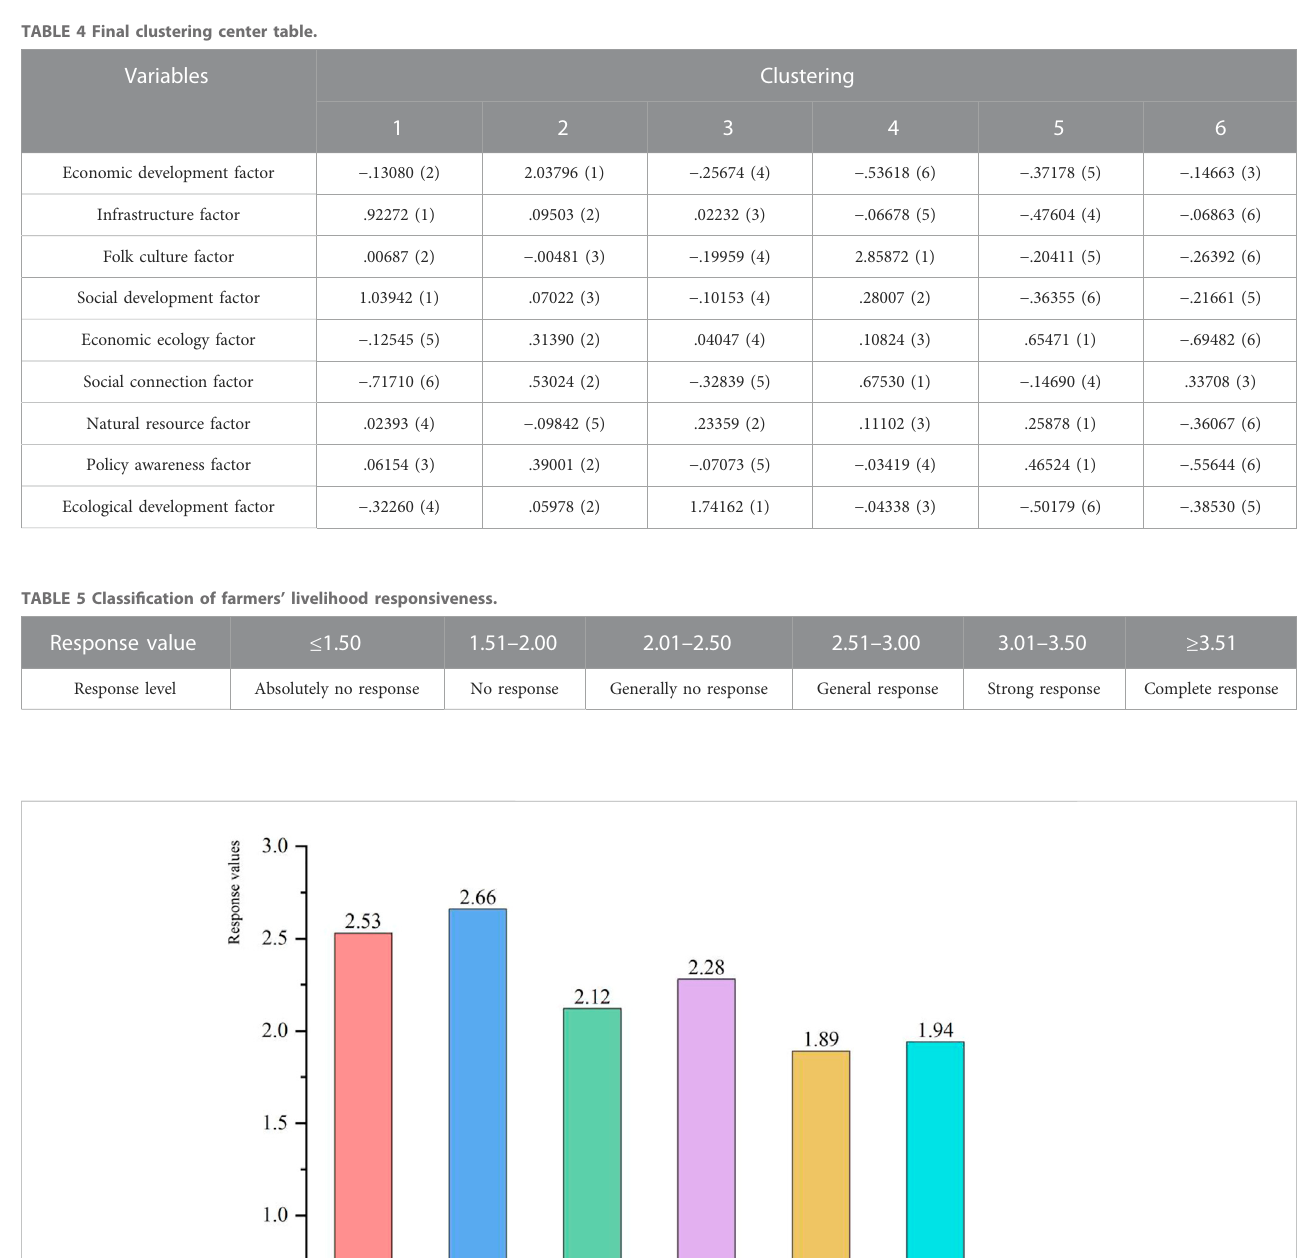
cluster 6, the infrastructure ( − 0.06863), folk culture ( − 0.26392), economic ecology ( − 0.69482), and policy awareness ( − 0.55644) factors had the lowest scores and were considered the “ developmental delay type. ”